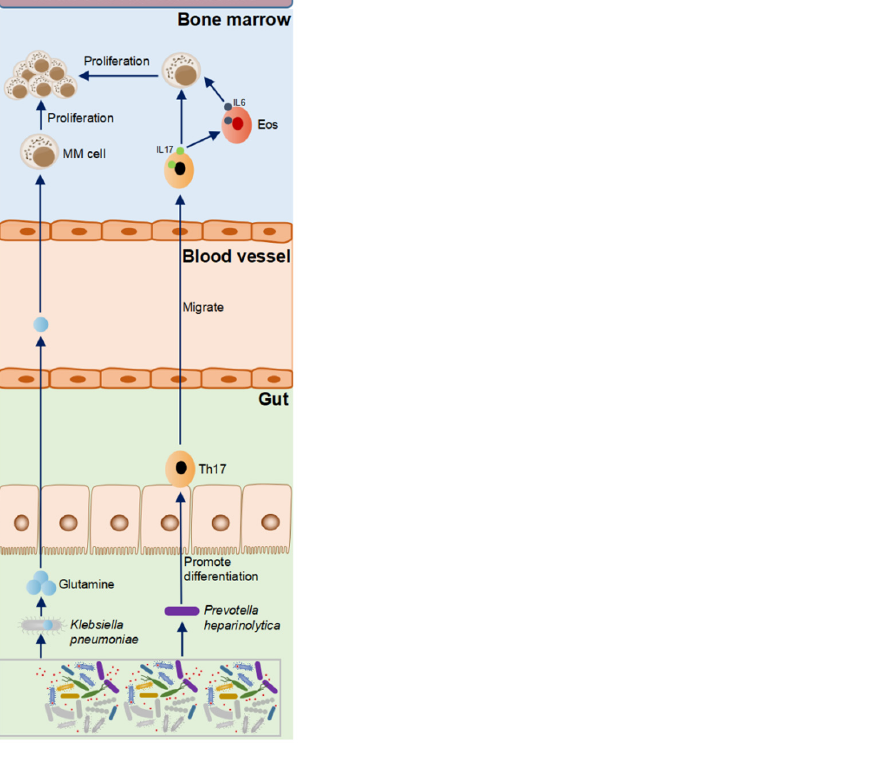
Figure 3. The mechanism of intestinal microbes affecting the progression of multiple myeloma.